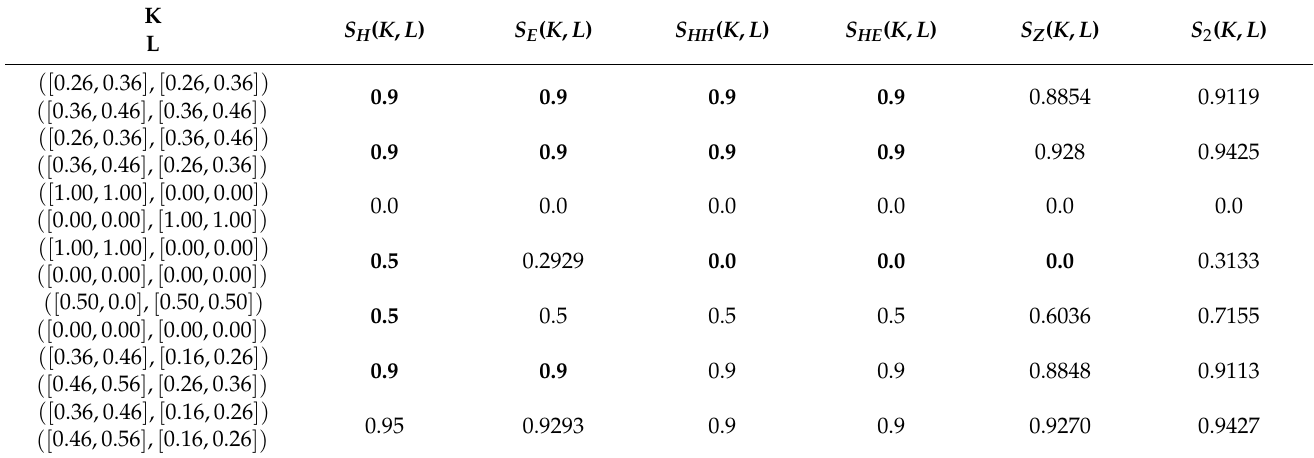
Table 1. Comparison results of introduced IPF-SM with extant